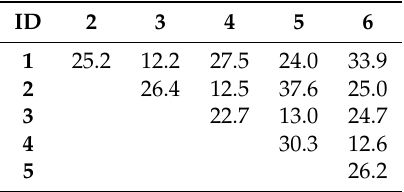
Figure 5. The test site Ljubljana (Slovenia): ( a ) topographic map (opentopomap.org (CC-BY-SA)), ( b ) RGB ortho-image and ( c ) relief shaded DSM. ( b , c ) were produced employing the proposed and implemented mapping workflow. Table 2. Convergence angles for all possible stereo pairs of the Ljubljana data set given in